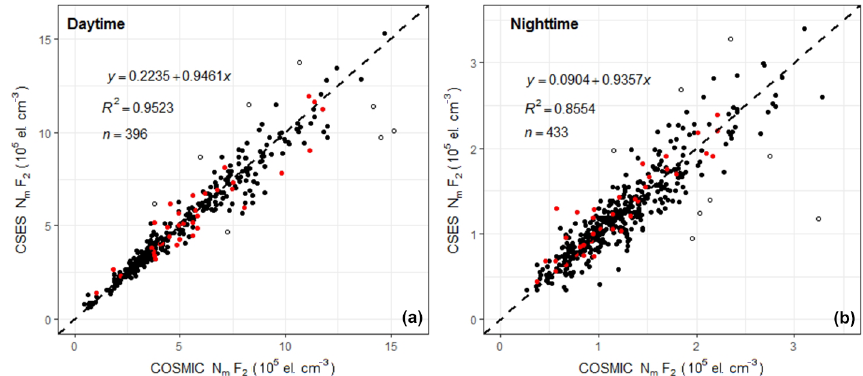
Figure 5. Scatter plot of Nm F2 for daytime and nighttime data. (The dashed line in a and b is the equal value line with a slope of 1.) Table 1. Absolute and relative error of Nm F2 between CSES and COSMIC. Correlation Absolute error Relative error coefficient Mean (cm − 3 ) RMSE (cm − 3 ) Mean RMSE Total 0.9898 0 . 005363 × 10 5 0 . 3638 × 10 5 1.97% 16.17% Daytime 0.9759 − 0 . 04346 × 10 5 0 . 5865 × 10 5 0.79% 12.76% Nighttime 0.9249 0 . 01215 × 10 5 0 . 1998 × 10 5 2.61% 18.14% Results of all the coefficients and absolute errors maintain four significant digits, and relative errors maintain two digits after decimal point. Zeros are padded after the decimal point for some results to maintain an identical power